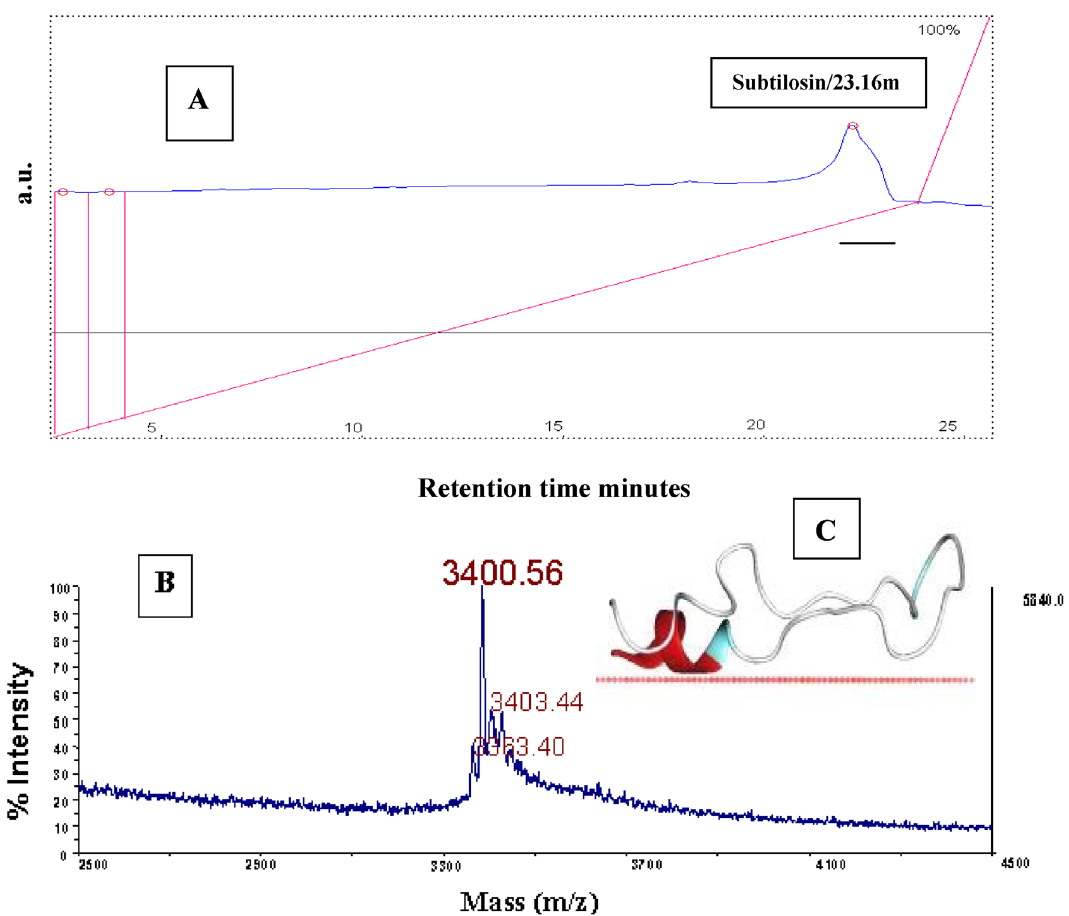
Figure 1. ( A ) RP-HPLC, ( B ) MALDI-TOF-MS, intensive signals correspond to the molecular mass of protonated subtilosin [M + H] + ( C ) 3D structure of